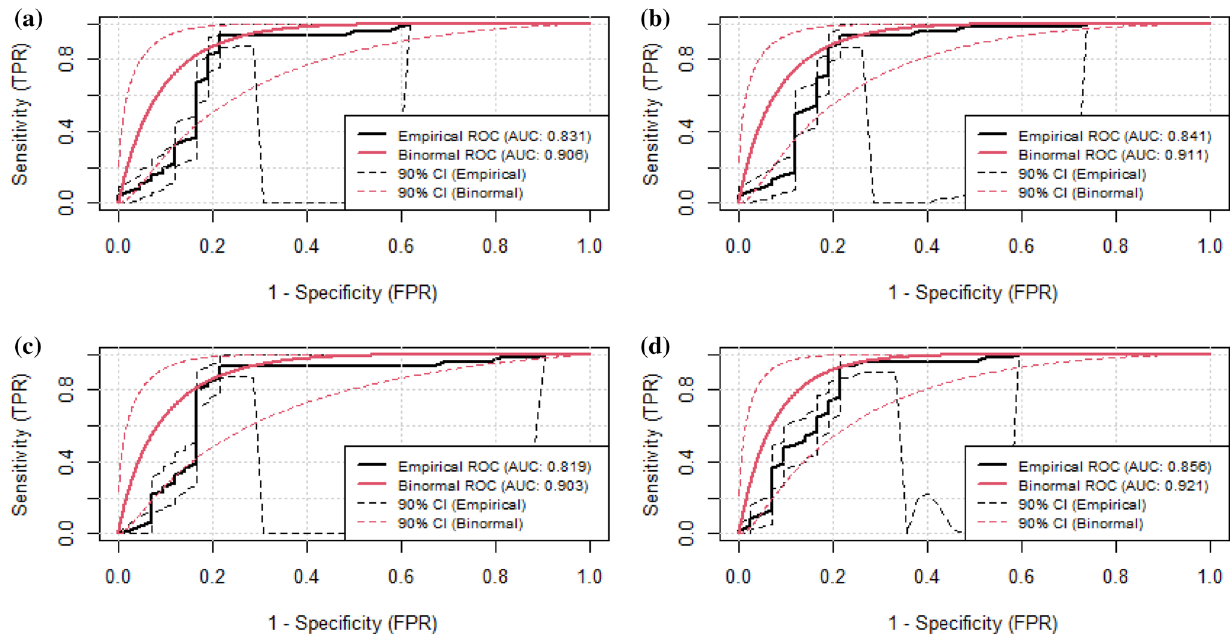
Fig. 7 Empirical and binormal ROC curves were used to validate the hybrid models, a SVM, b ANN, c LR, and d stacking Fig. 8 Analyses of sensitiv- ity for the best model (AND model) using a MDA and b